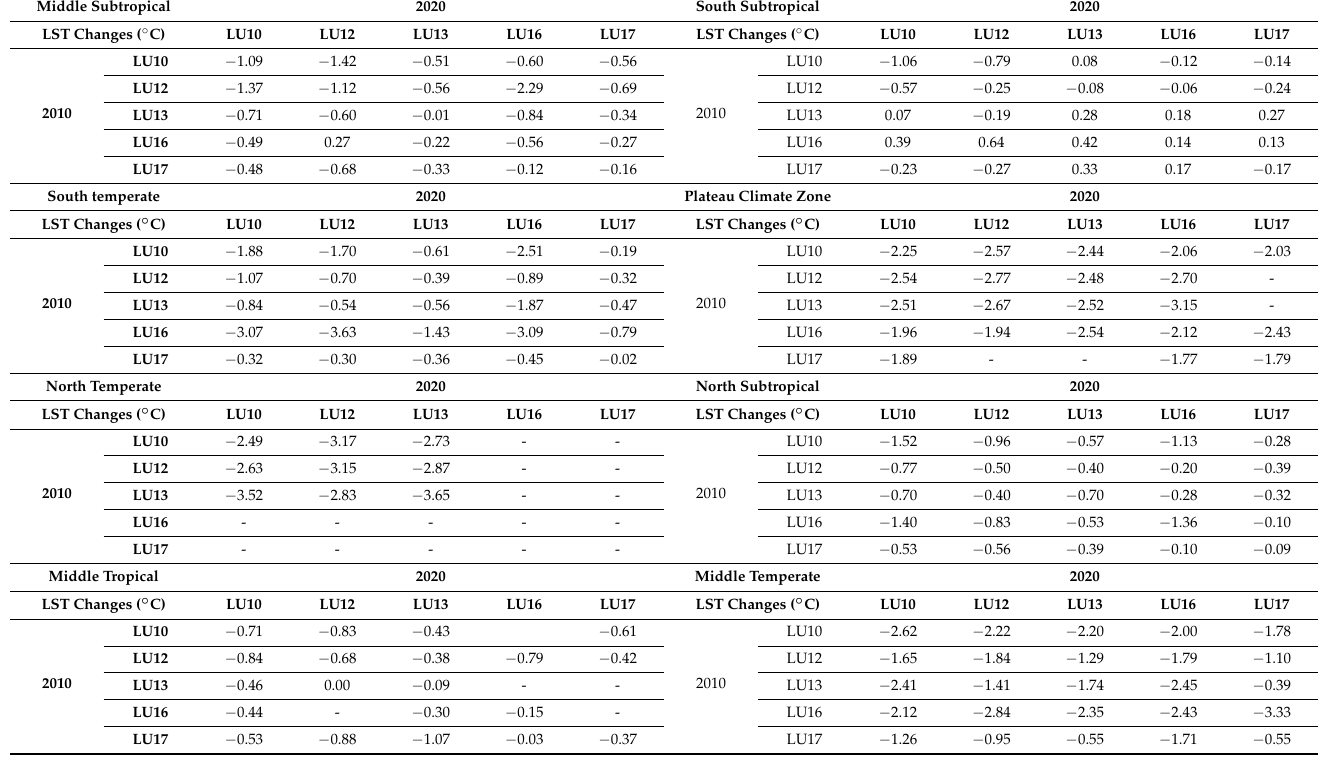
Table 4. Variations in land surface temperatures (LSTs) for different land use/land cover (LULC) types from 2010 to